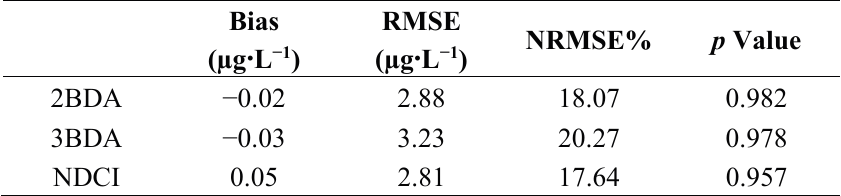
Table 9. Summary results for validation process applied to OLCI simulated